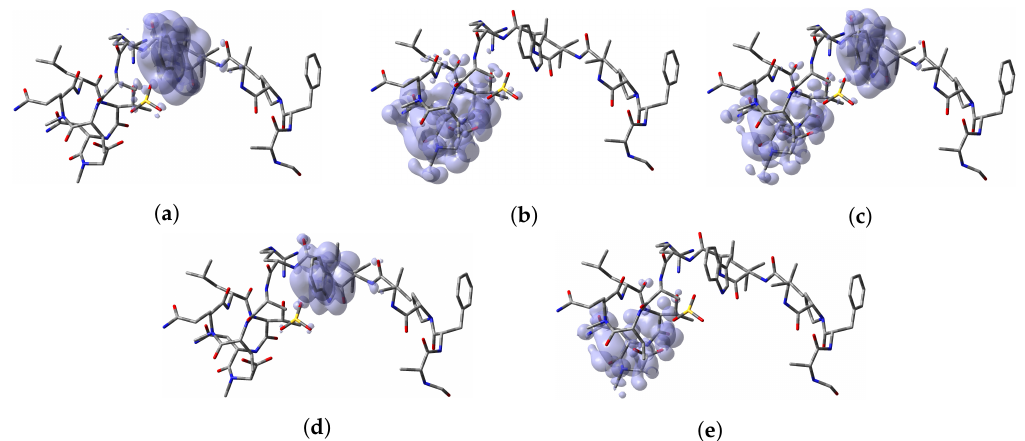
Figure A6. Graphical sketches of the local reactivity descriptors for Discodermin F showing the reactivity regions: ( a ) Electrophilic Fukui Function f − , ( b ) Nucleophilic Fukui Function f + , ( c ) Radical Fukui Function f 0 , ( d ) Electrophilic Parr Function P − and ( e ) Nucleophilic Parr Function P + . Table A7. Condensed local reactivity descriptors for Discodermin G denoting the reactivity sites: Electrophilic Fukui Function f − , Nucleophilic Fukui function f + , Radical Fukui Function f 0 , Electrophilic Parr Function P − and Nucleophilic Parr Function P + .